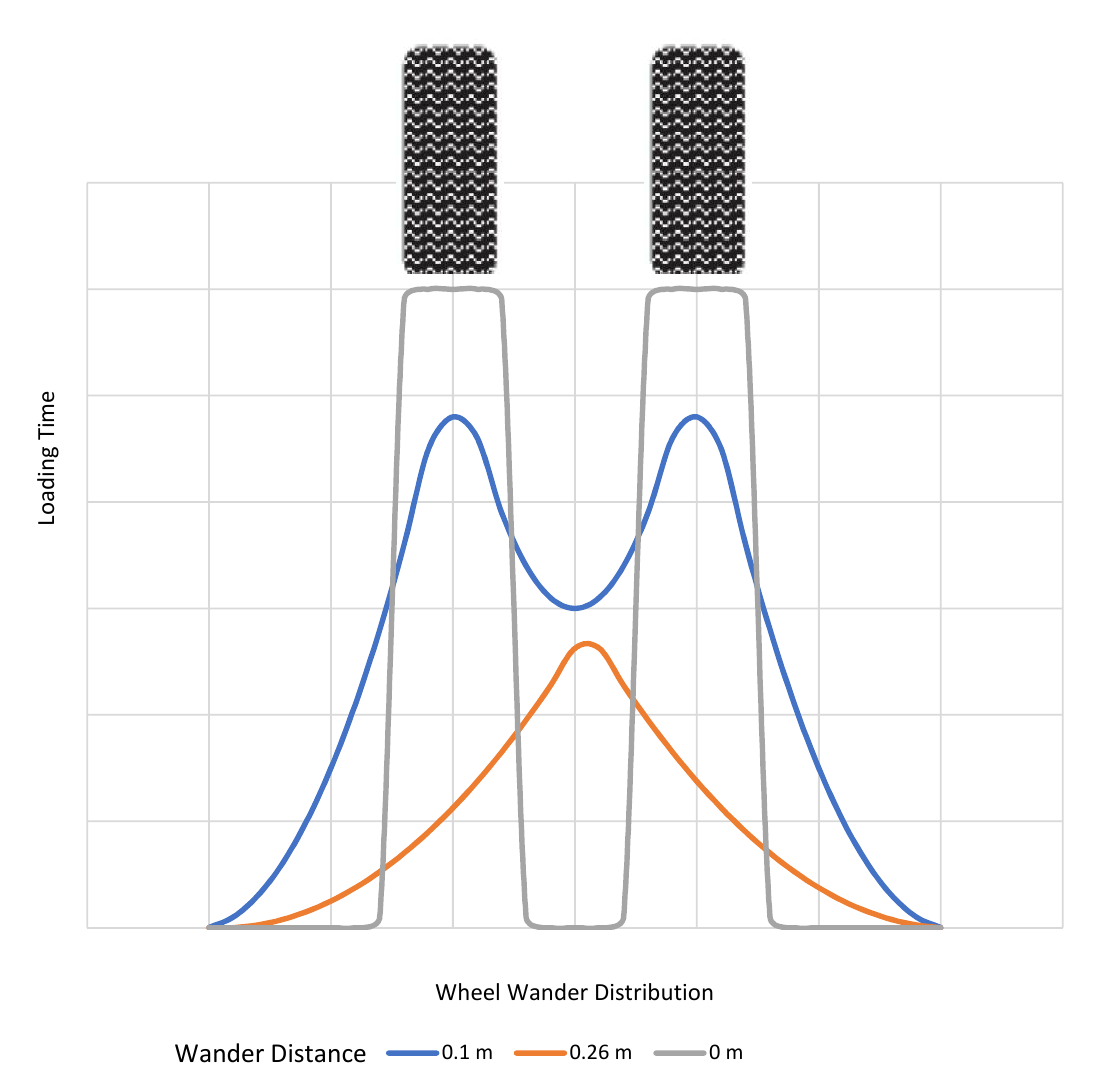
Figure 11. Loading time distributions by the level of wheel wander distance (adopted from [79]).